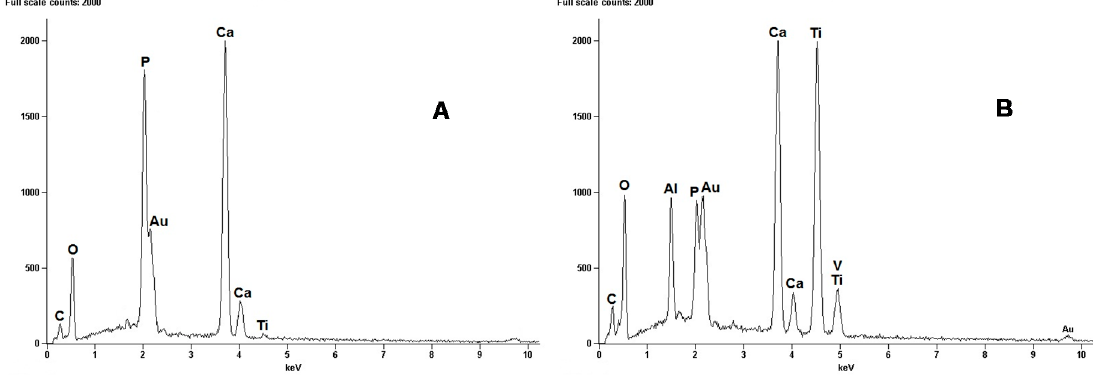
Figure 6. EDX for samples observed by SEM: ( A ) HAp coated sample and ( B ) uncoated sample.